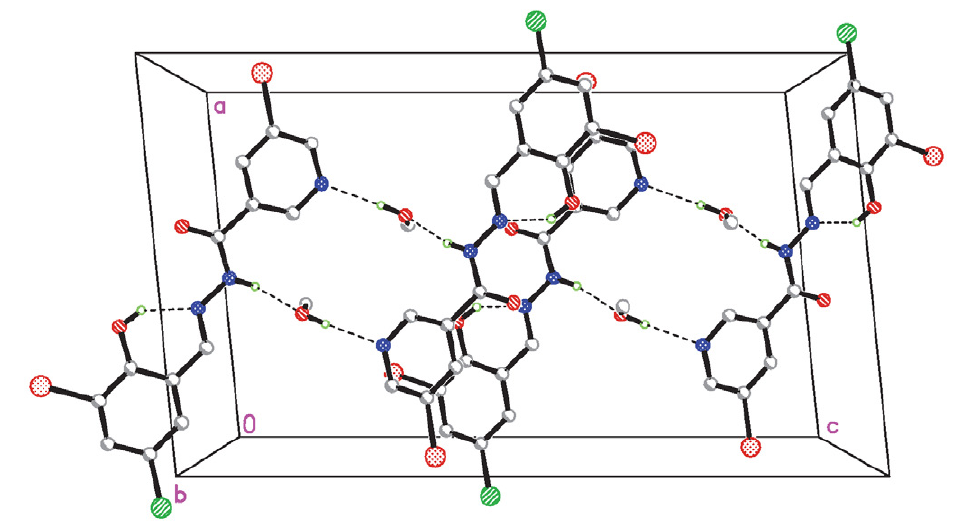
Figure 4. Molecular packing of 2 , viewed along the b axis. Hydrogen bonds are drawn as dashed